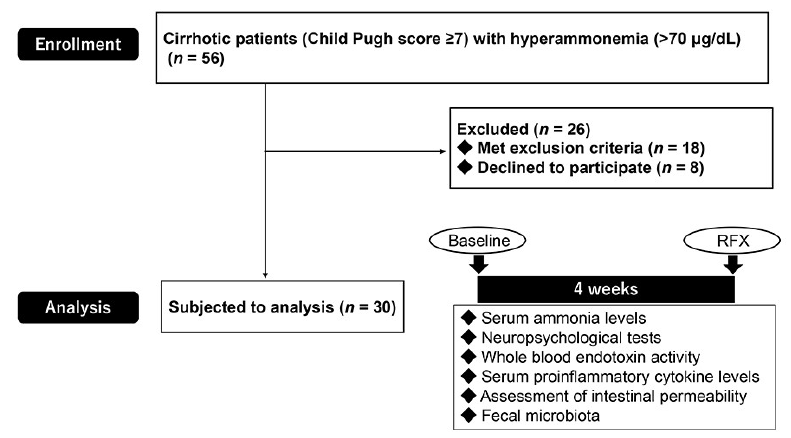
Figure 1. The selection of the study population and experimental design. A final number of 30 patients (after excluding 26 patients who met the exclusion criteria or declined to participate) were analyzed. Table 1. Characteristic features of patients ( n =